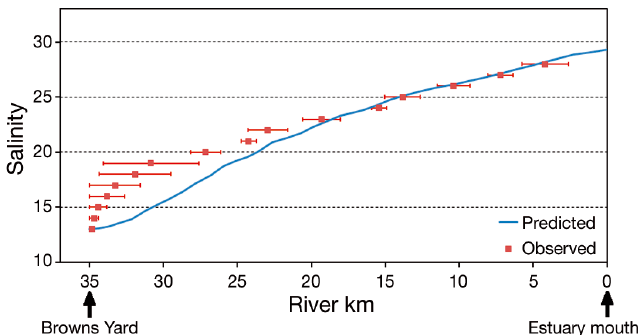
Fig. 4. Comparison of the observed and model predicted lon- gitudinal distribution of salinity along the Richibucto River in low freshwater discharge conditions. Horizontal bars show the longitudinal extent of a given salinity contour due to vertical